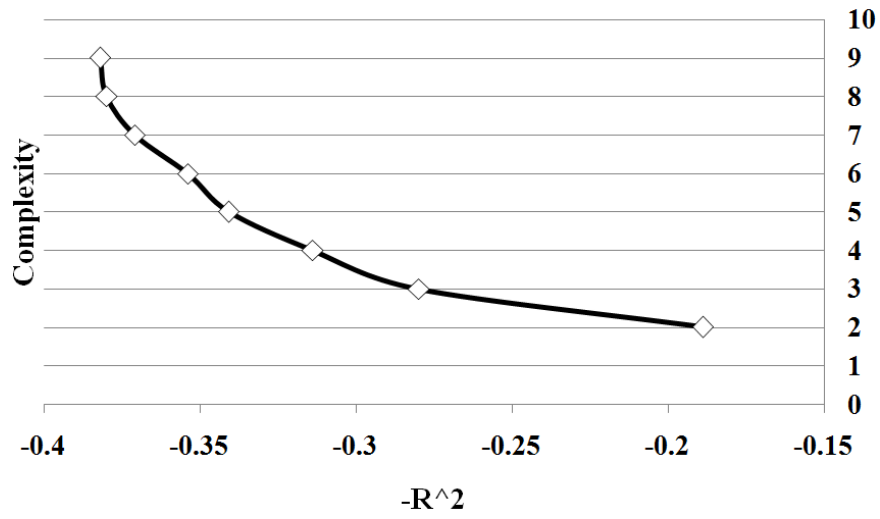
Figure 5. Case II Pareto Front: Pareto front showing the relation between − R 2 and complexity for Case II. The values are average of 10 runs of 100 simulation replicates.